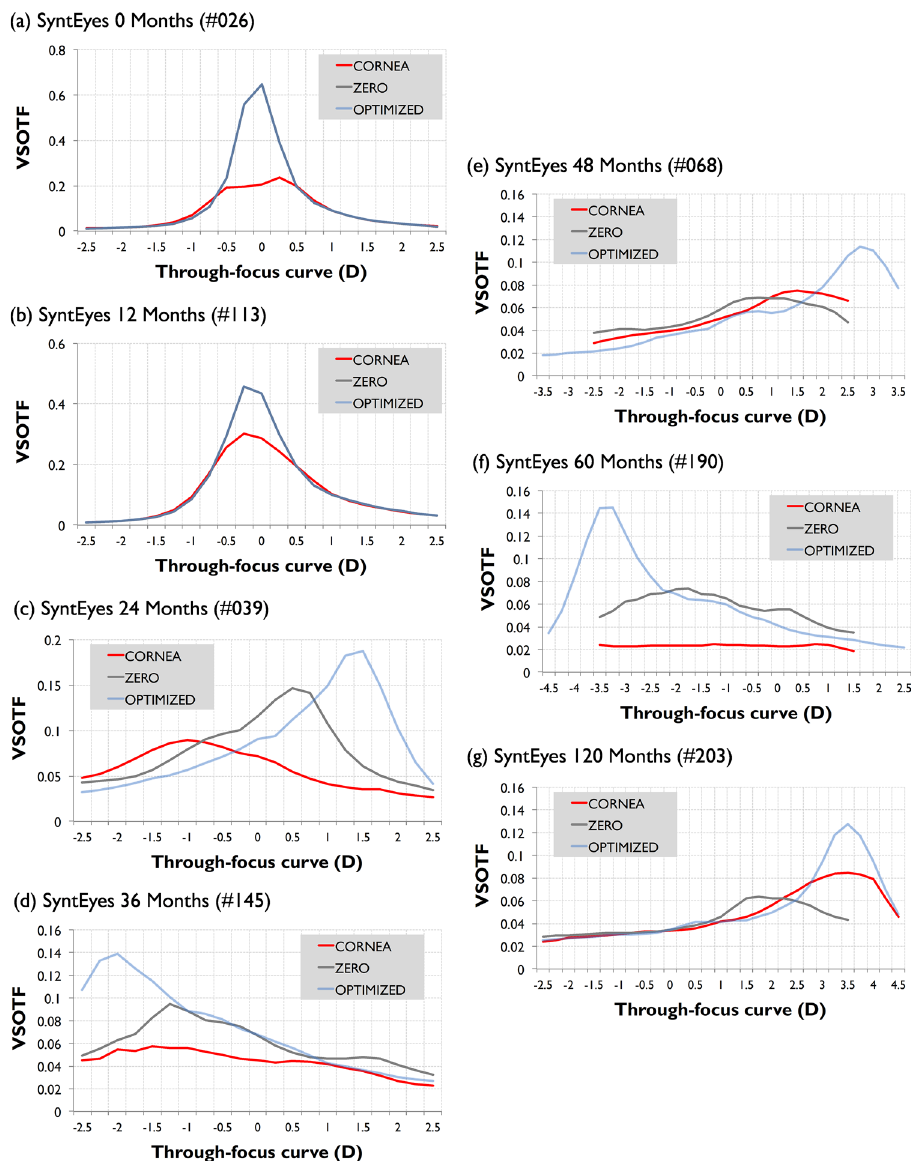
Figure 2. Through-focus Visual Strehl (VSOTF) for representative examples of each SyntEye group: uncorrected cornea (red), zero-target (grey) and optimized (light